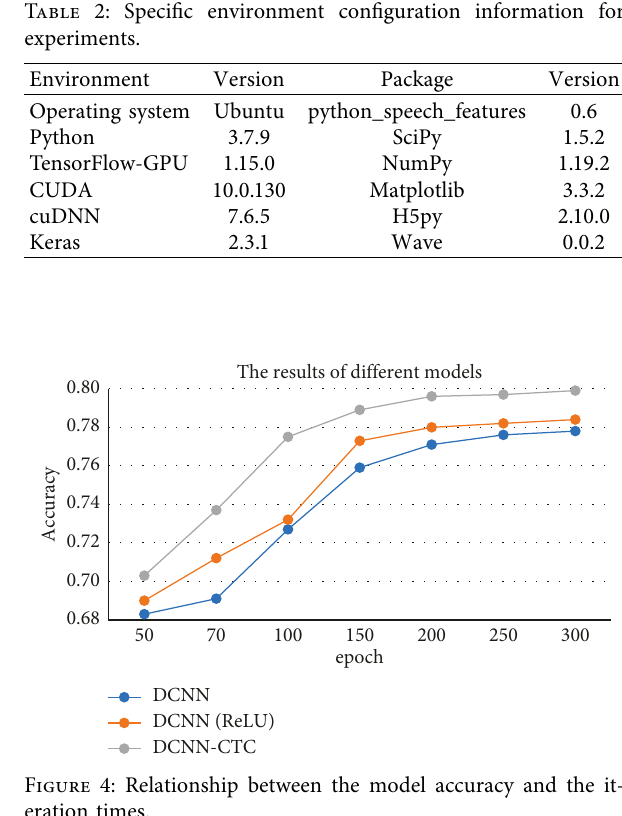
Table 2: Specific environment configuration information for